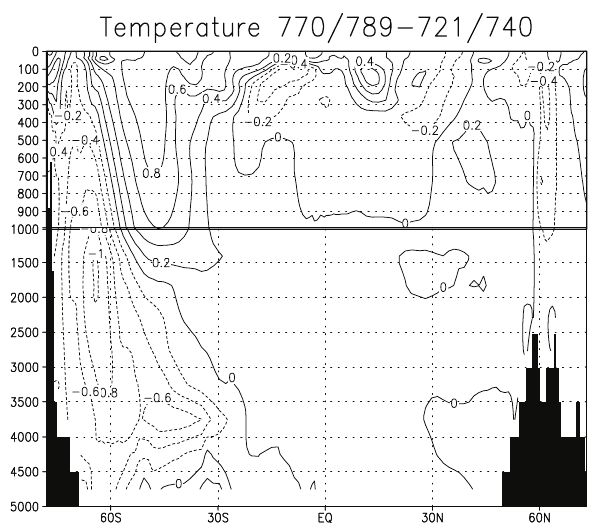
Fig. 6. Difference for two extreme periods (770/789- 721/740). Top: global overturning stream function (Sv). Bottom : oceanic temperature ( °